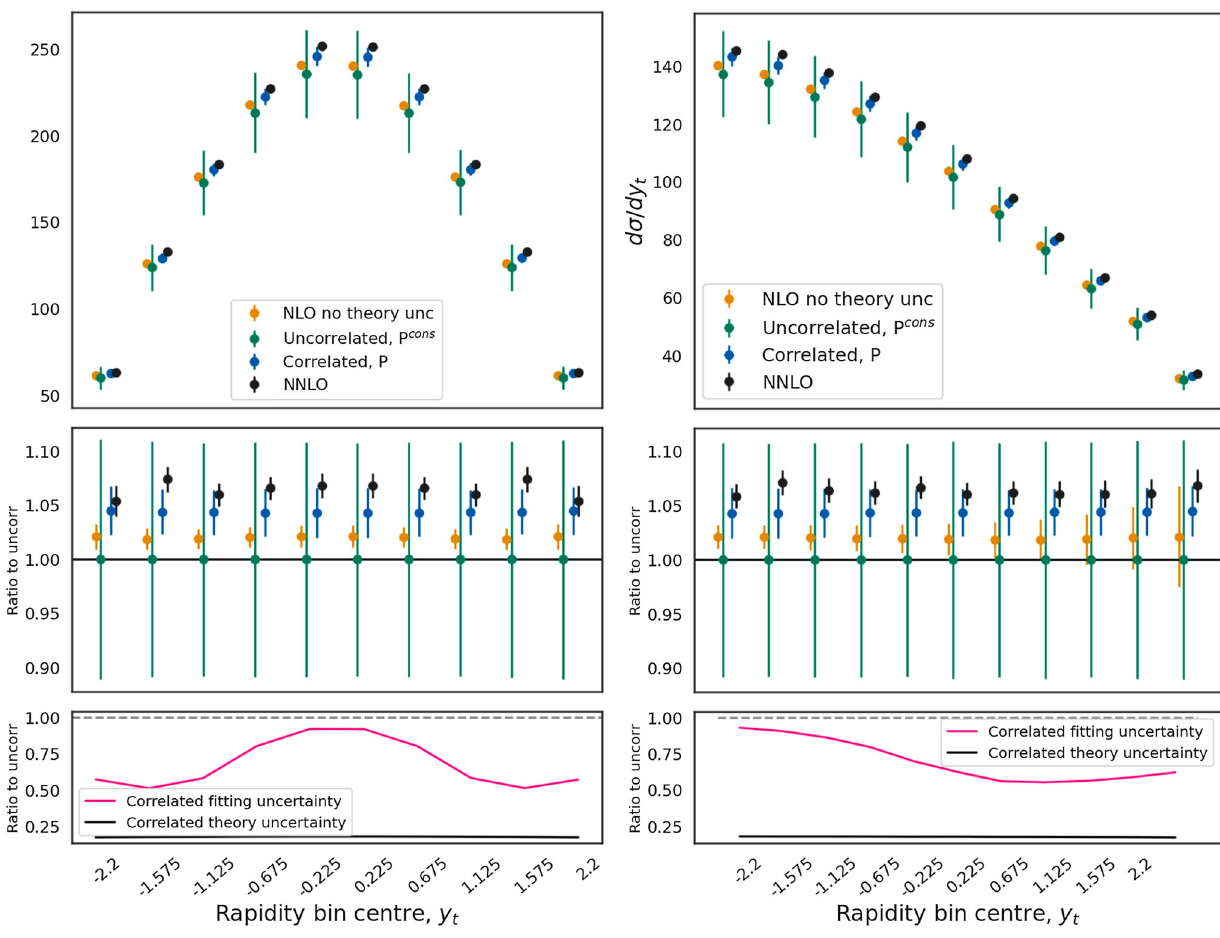
Fig. 12 The upper two panels show predictions for t ¯ t unnormalized rapidity distribution data taken at 13 TeV by CMS, the dilepton rapidity distribution [17] (left) and the lepton+jets distribution [18] (right). The four predictions show: the NLO fit with no MHOUs, PDF error only; the combined PDF and MHOU fit, ignoring correlations (thus the correlatedresult includingtheshift, and uncertaintycomputed using